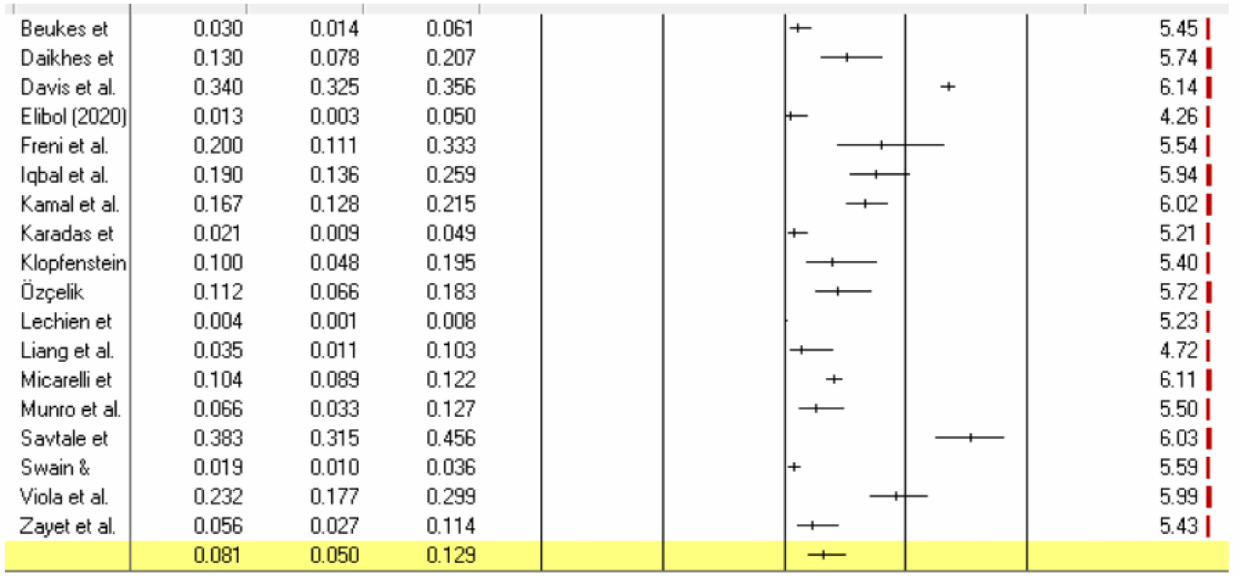
Figure 2. Forest plot for the estimated prevalence of tinnitus in suspected and probable COVID-19 cases. The individual study estimate, and the 95% CI are represented by center lines and their error bars,